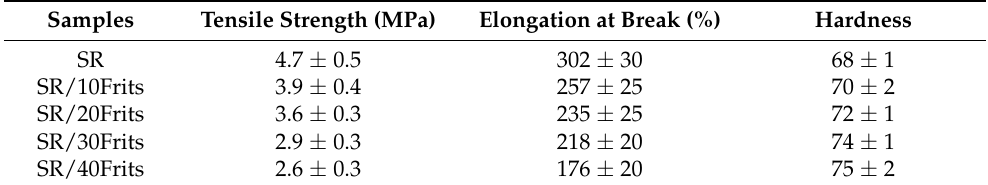
Table 4. Tensile strength, elongation at break, and hardness of SR/frit composites. Samples Tensile Strength (MPa) Elongation at Break